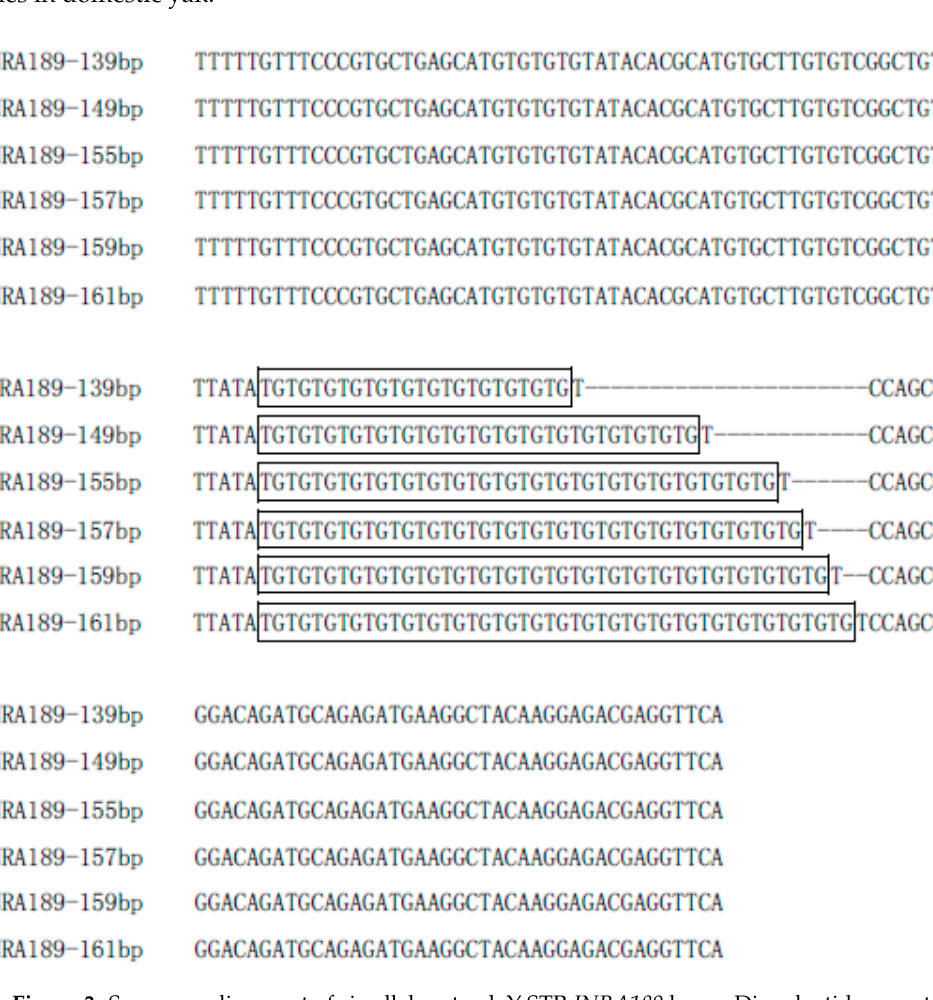
Figure 3. Sequence alignment of six alleles at yak Y-STR INRA189 locus. Dinucleotide repeat motif is marked by square box. Horizontal lines (-) denote nucleotide InDel sites.